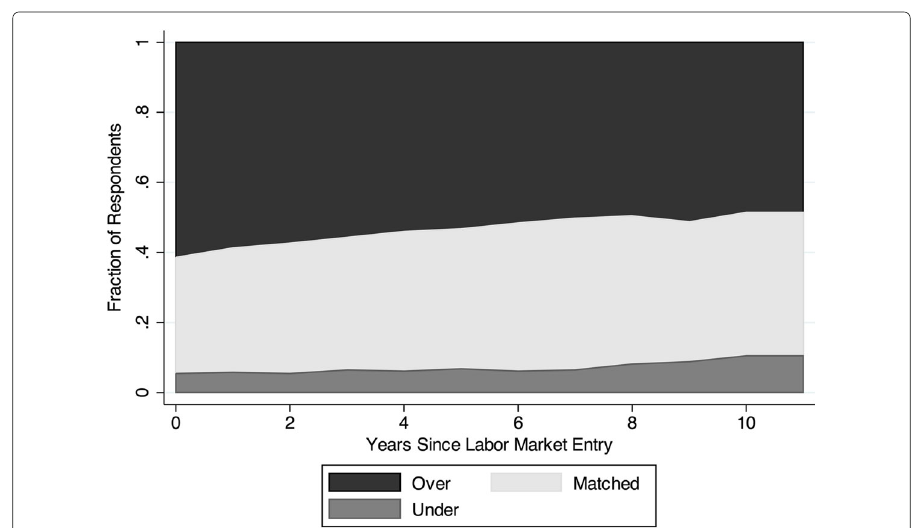
Fig. 2 Composition of overeducation (fraction of respondents)